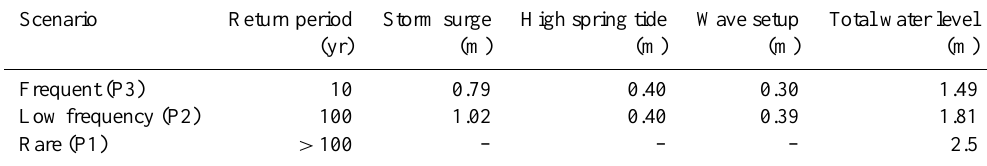
Table 2. Total water level values of each scenario. Comments on RP > 100 can be found in the